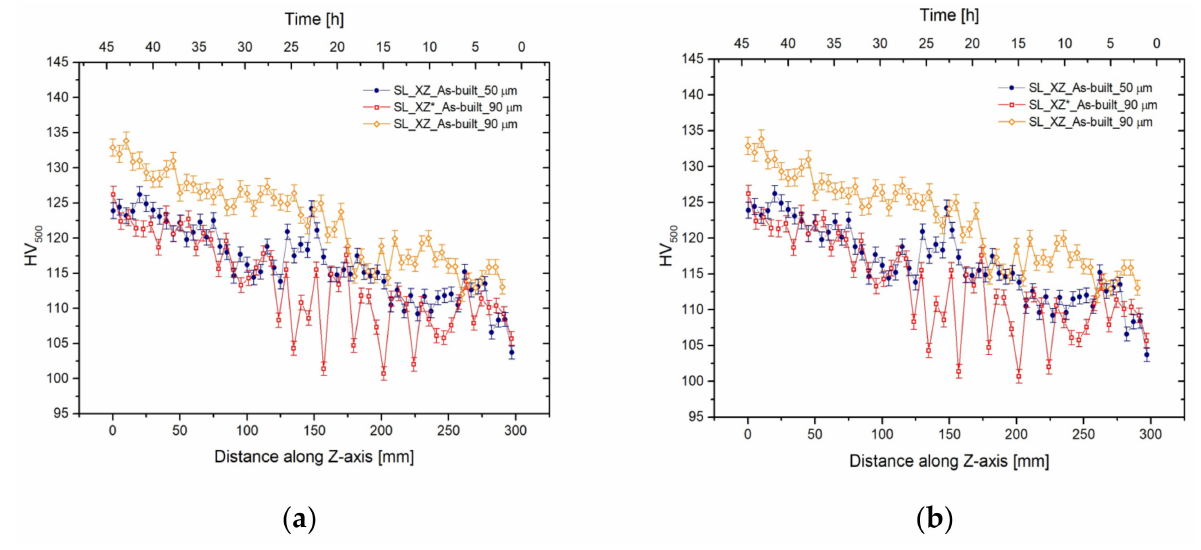
Figure 5. Microhardness profile of as-built SL ( a ) and DL ( b ) 90-samples carried out along the build direction (Z-axis). The blue and orange curves are related to the centre of 50-bars and 90-bars, respectively. The red curve represents the microhardness profile of the external frame of 90-samples. Table 3. Density values of AlSi10Mg 90-samples and 50-samples in as-built condition and after the heat treatments. HT